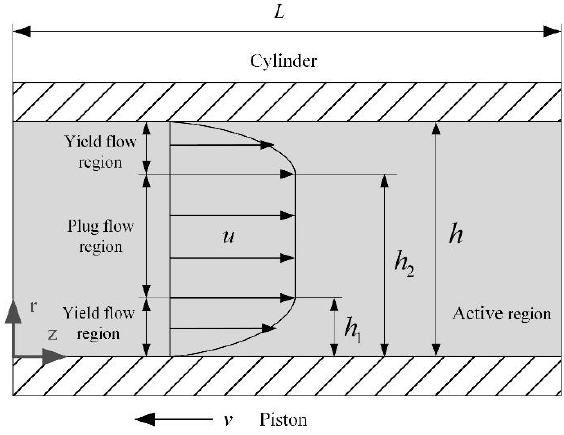
Figure 9. Fluid flow and velocity distribution of the MR fluid.